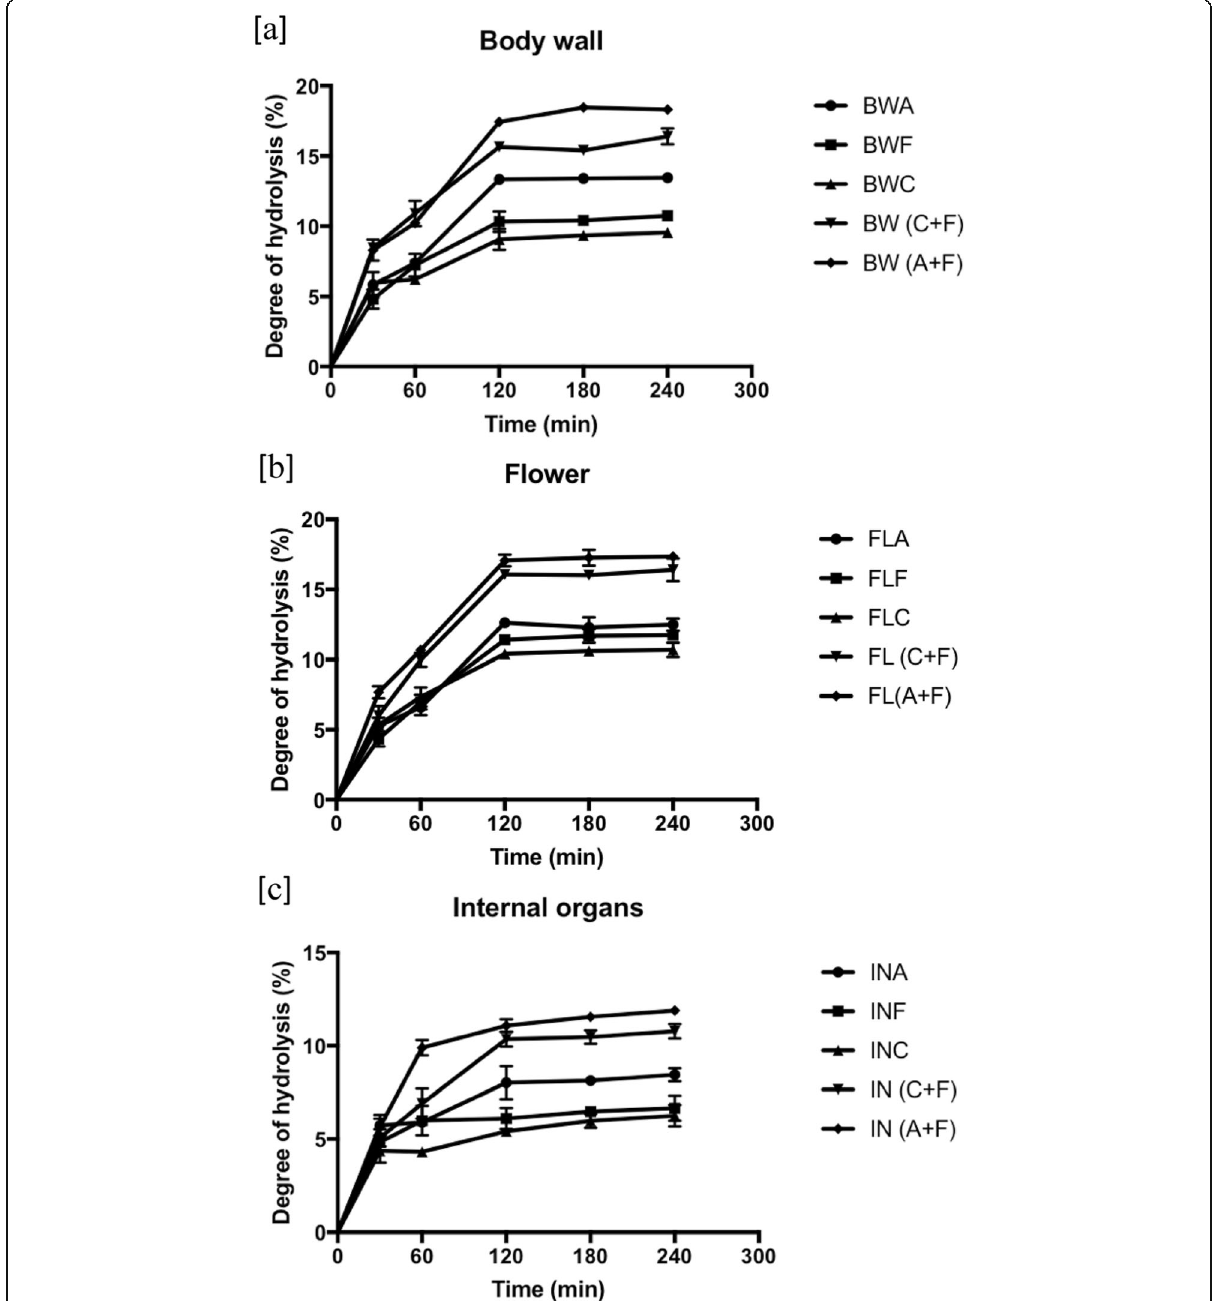
Fig. 3 Degree of hydrolysis (DH) of sea cucumber C. frondosa protein hydrolysates a BW, Body wall; b FL, Flower; and c IN, Internal organs; A, Alcalase; F, Flavourzyme; C, Corolase; C + F, Mixture of Corolase and Flavourzyme; and A + F, Mixture of Alcalase and